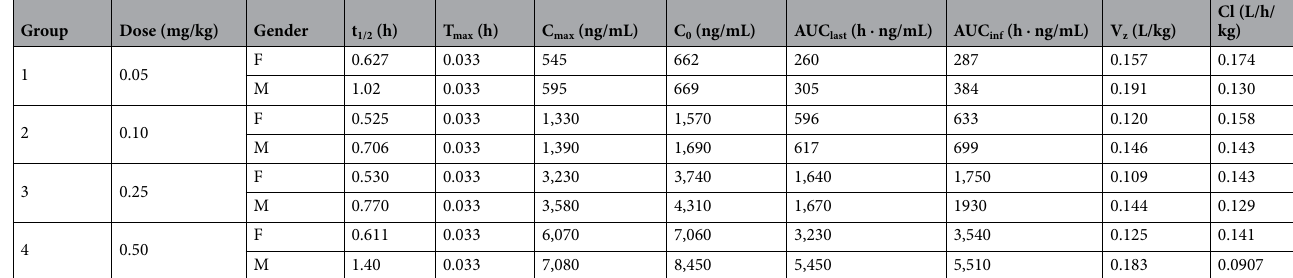
Table 1. EC2629 plasma pharmacokinetic parameters following intravenous administration to